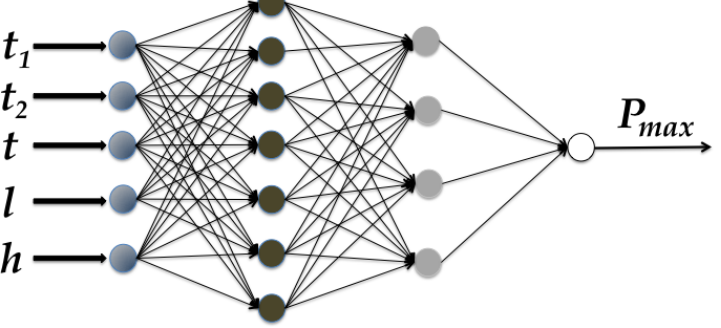
Figure 9. The implemented feed-forward neural network (FFNN)